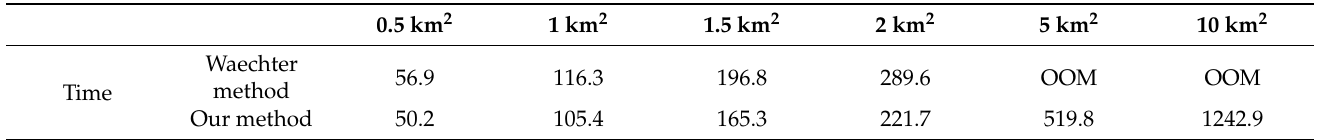
different experimental